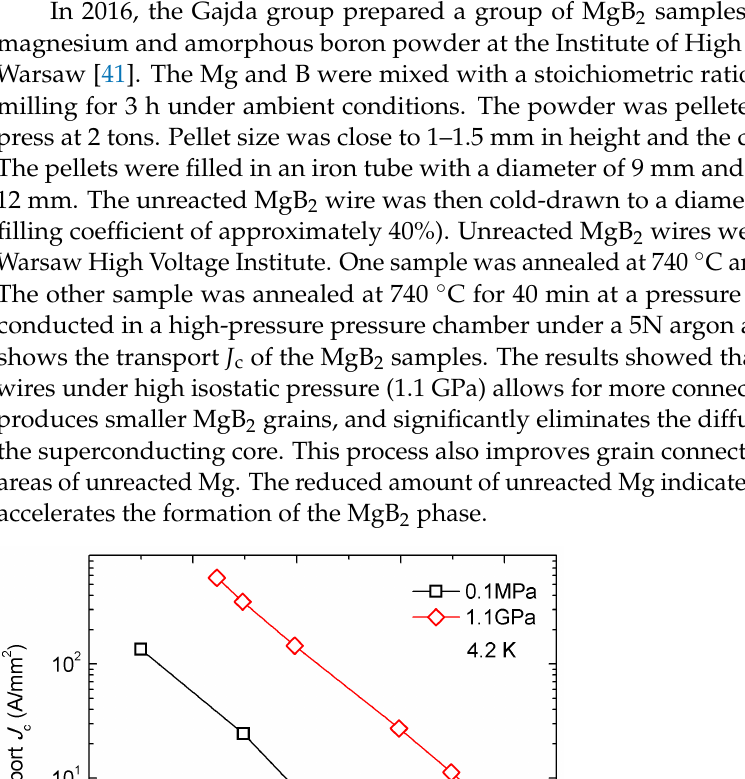
Figure 7. Transport J c of the ( a ) undoped MgB 2 samples at a pressure of 1 GPa and 0.1 MPa and ( b ) SiC-doped MgB 2 samples at a pressure of 1 GPa and 0.1 MPa. Some data are based on [40].